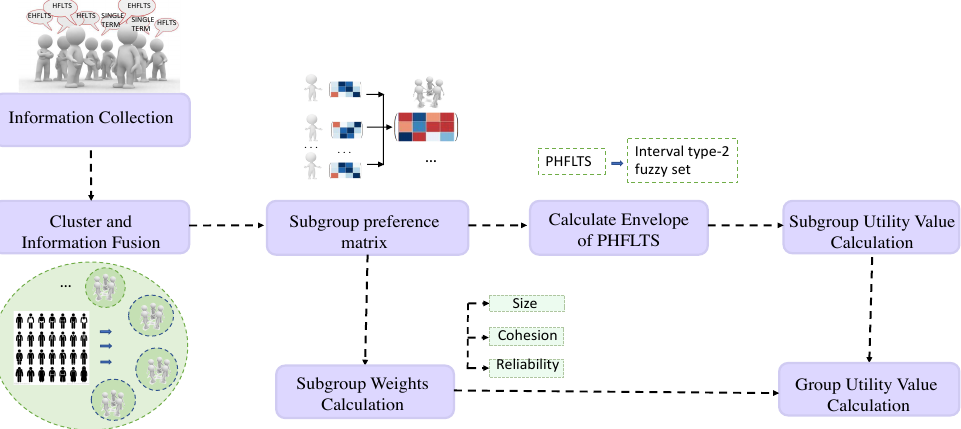
Figure 4. Large-scale muti-attribute linguistic group decision making. (1) Information